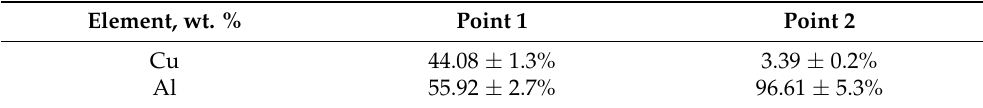
Figure 3. SEM images of a cross section of sample 1 (0.1 mm radius of oscillation): ( a ) SEM image of the obtained joint; ( b ) higher magnification SEM image of the copper–fusion zone (FZ) interface; ( c ) higher magnification SEM image of the fusion zone (FZ); ( d ) higher magnification SEM image of the fusion zone (FZ)–aluminum alloy interface; ( e ) SEM image of a magnified section of the fusion zone (FZ). Table 2. Chemical composition of each point marked on the SEM images of the fusion zone of sample 1 in Figure 3e.